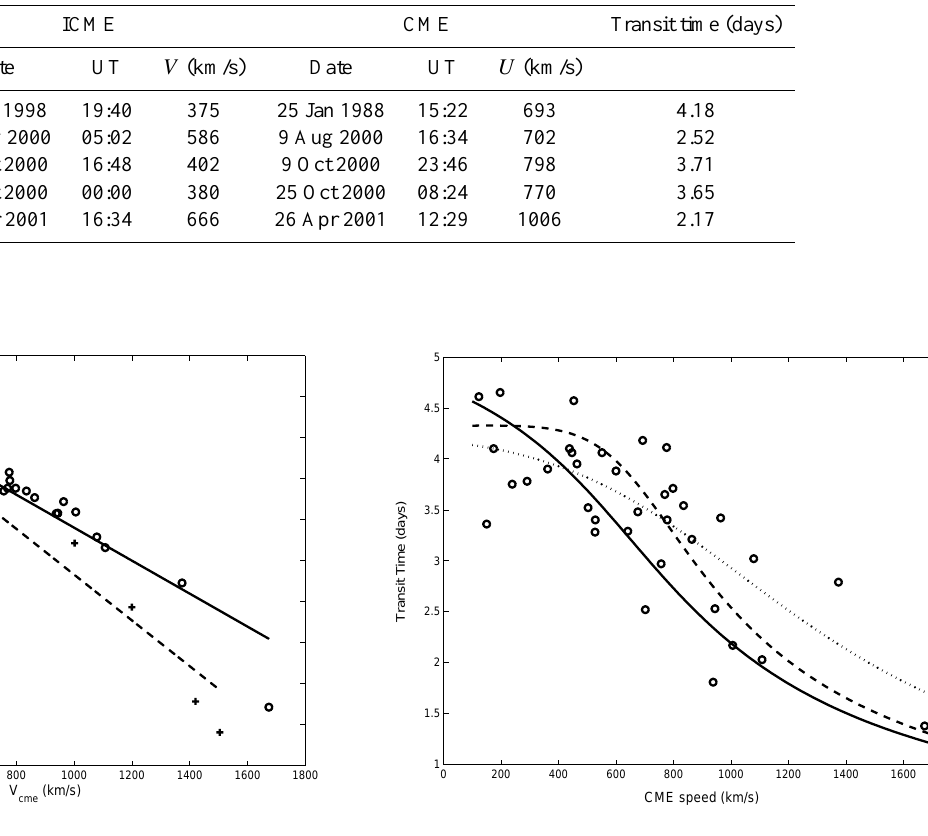
Fig. 1. The interplanetary acceleration as a function of the CME speed ( U ) at the Sun. The open circles correspond to the 35 CME – ICME pairs observed along the Earth-Sun line and the solid line shows the linear fit: a 1 ( km / s 2 ) = − 10 − 3 [ 0 . 0040 U( km / s ) − 1 . 8 ] . The plus signs correspond to the 19 CME – ICME pairs observed in quadrature, and the dashed line shows the linear fit: a 2 ( km / s 2 ) = − 10 − 3 [ 0 . 0054 U( km / s ) − 2 . 2 ] .